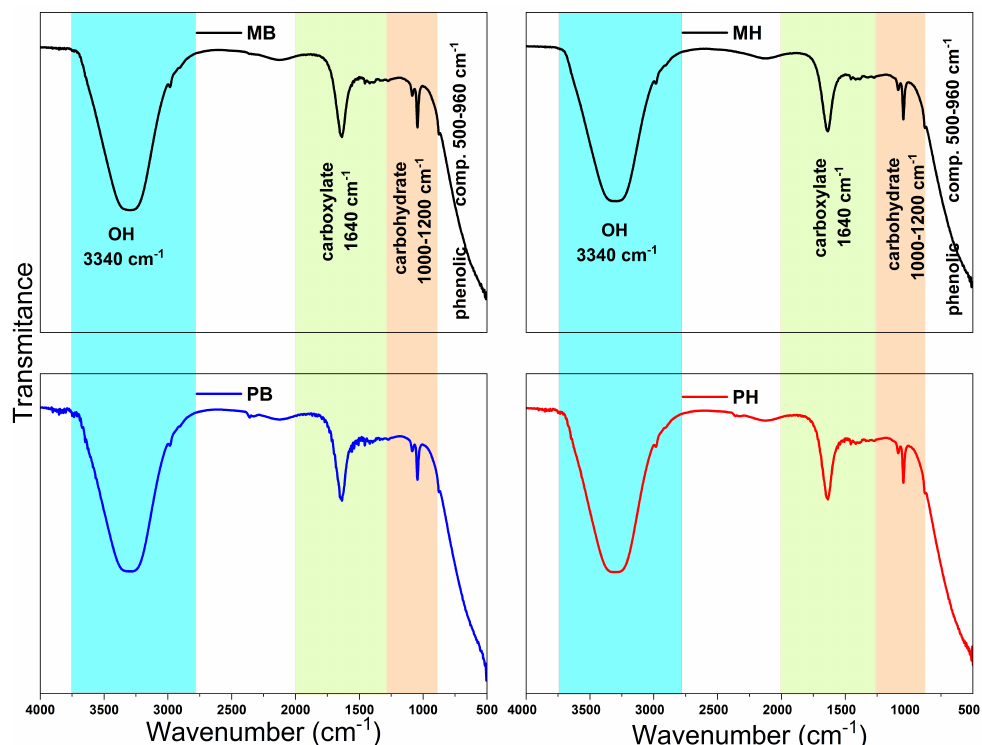
Figure 5. The IR transmittance spectra of untreated and plasma treated wine samples (1y old).